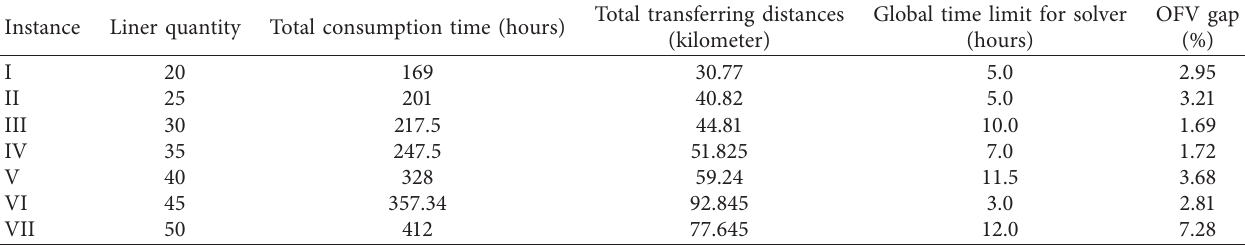
Table 8: High-quality satisfactory solutions obtained by CPLEX solver.